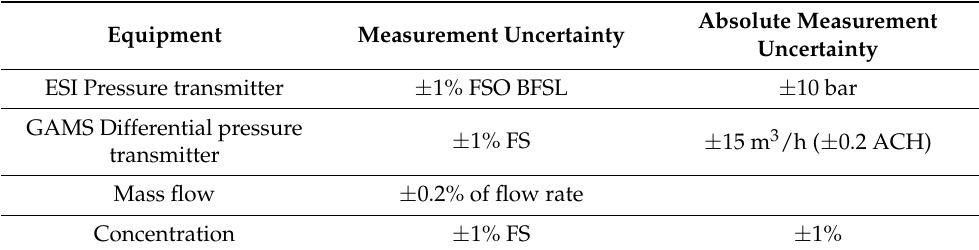
Table 1. Uncertainty of measurements.